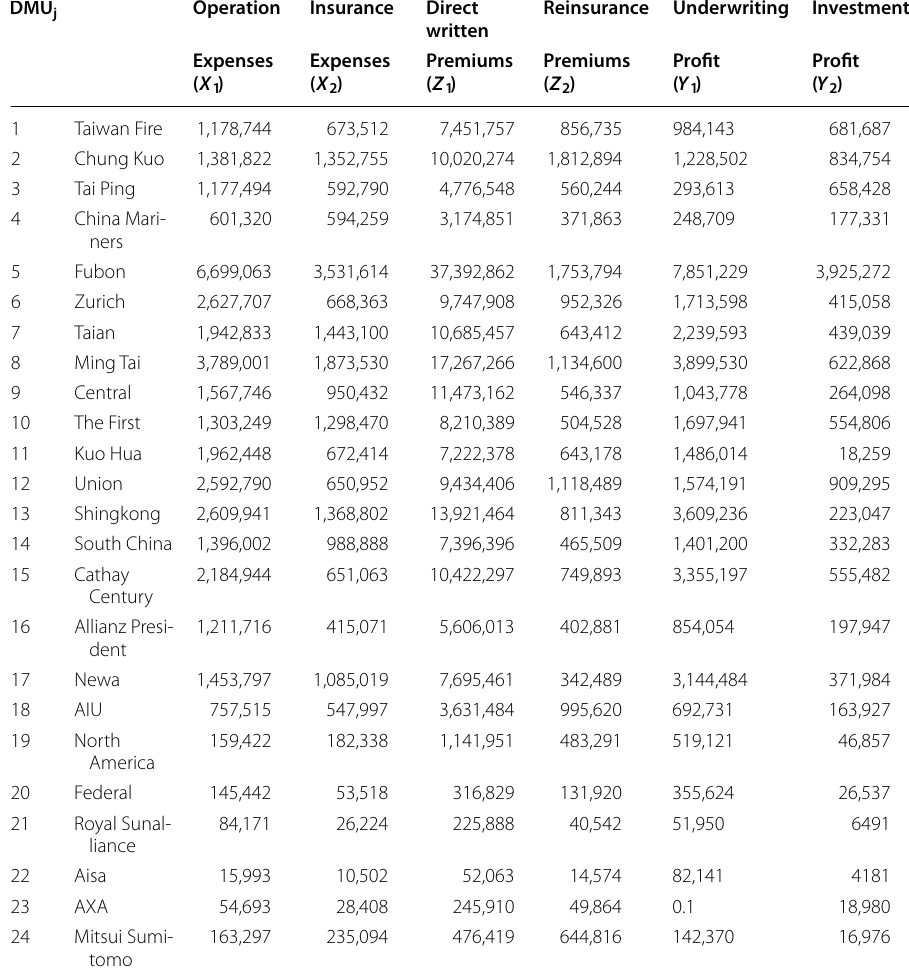
Table 6 Example 3. Data set for 24 Taiwanese non-life insurance companies (Kao and Hwang 2008) DMU